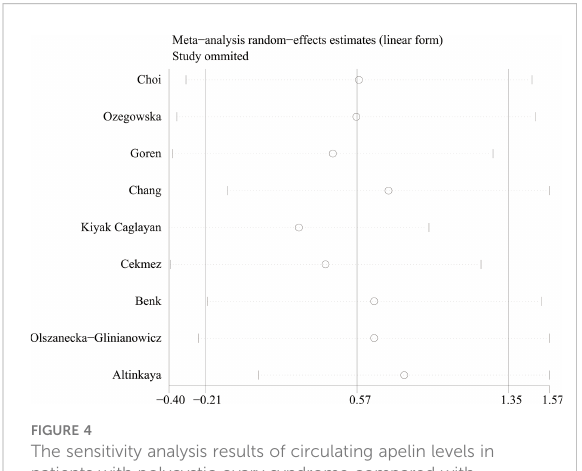
FIGURE 4 The sensitivity analysis results of circulating apelin levels in patients with polycystic ovary syndrome compared with controls.